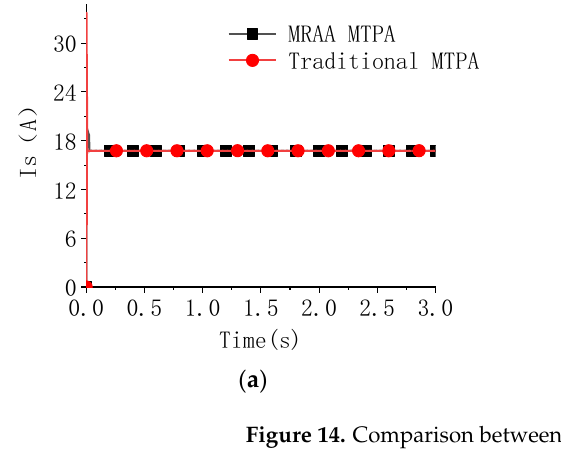
Figure 13. Speed comparison between MRAA-MTPA control and fixed-parameter MTPA control. ( a ) Comparison of speed and ( b ) the local magnification of the anterior segment.